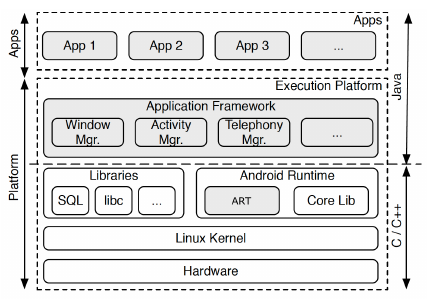
Figure 2. Android architecture.